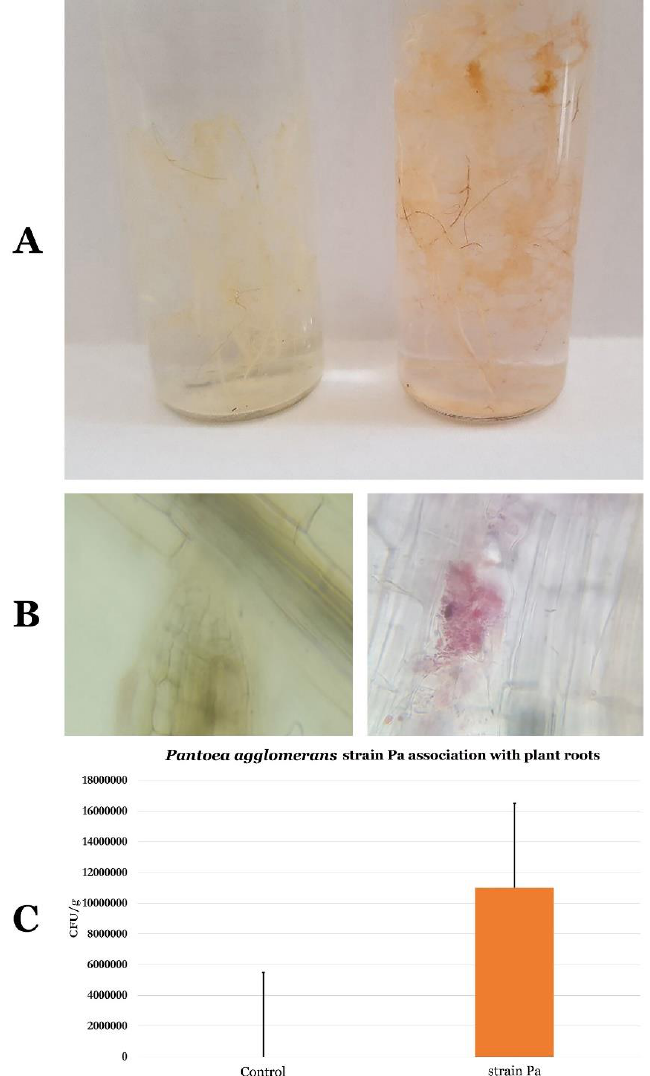
Figure 7. P. agglomerans strain Pa lifestyle. ( A ) Control plant roots (left) and P. agglomerans strain Pa adherence to plant roots (right). ( B ) Control plant roots (left) and P. agglomerans strain Pa staining within the plant root tissues (right). ( C ) Natural logarithm of colony-forming unit (Ln CFU) of P. agglomerans strain Pa association per gram of plant